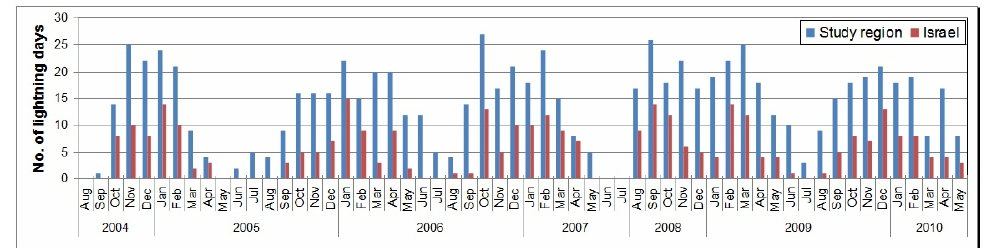
Fig. 3. The number of lightning days over the study region and over Israel for each month of the study period. A lightning day is defined here as a day on which at least one flash was captured.